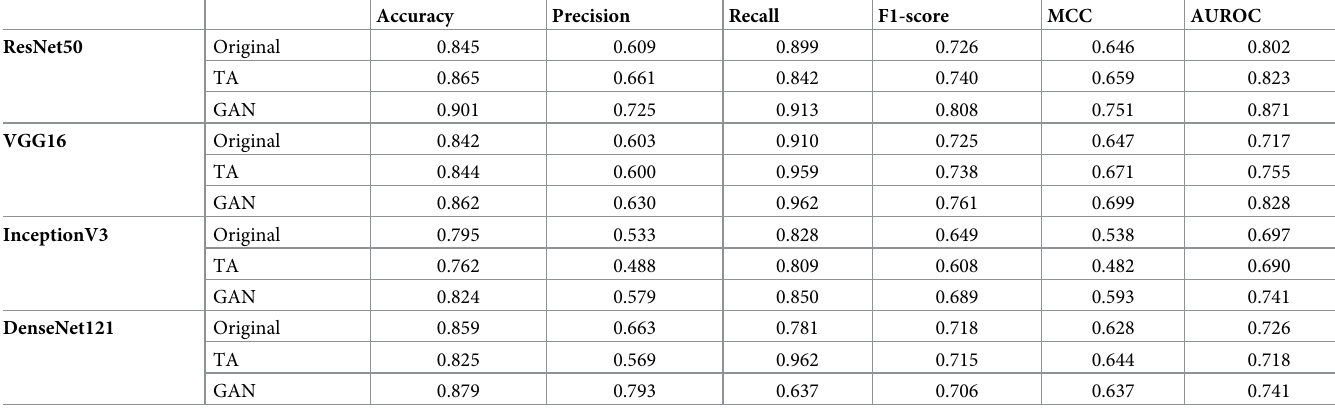
Table 7. Binary classification performance of each CNN classifier.